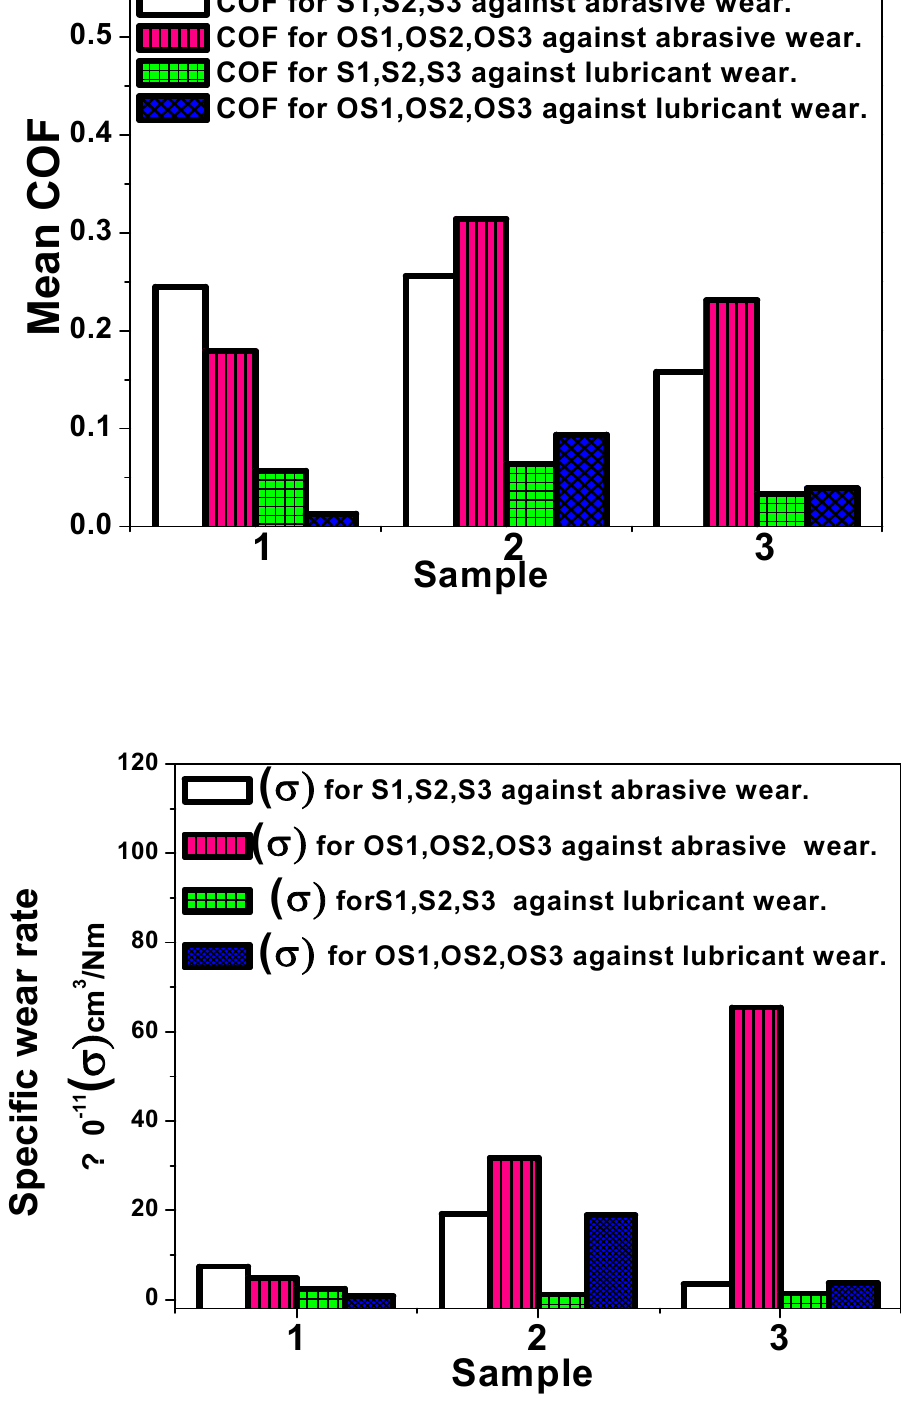
Figure 9. The mean friction coefficient COF and the specific abrasive wear rate ( σ ) values under abrasive and lubricant wear conditions for the stainless steel grades, before and after the heat treatment process.